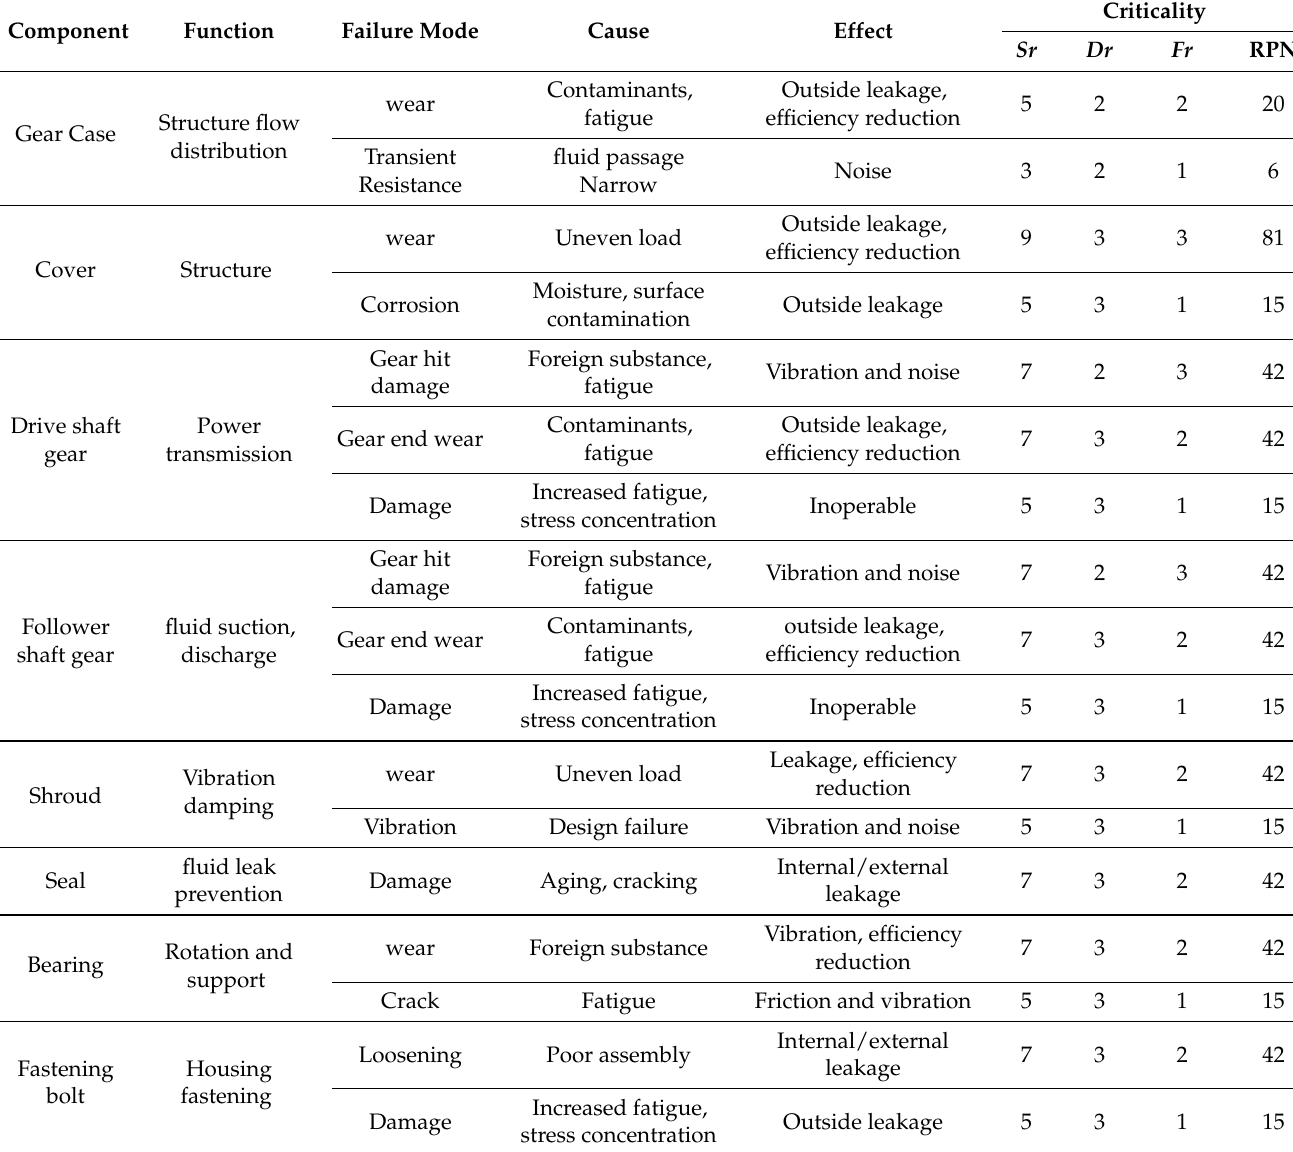
Table 1. FMECA results on AP3.5/100 external gear pump manufactured by